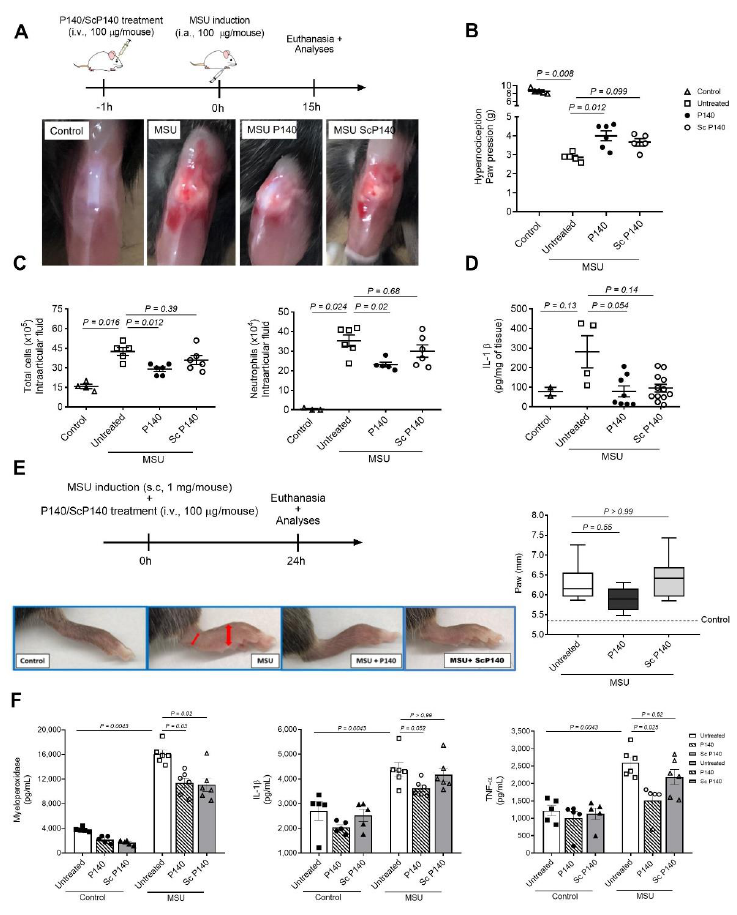
Figure 1. In vivo effect of P140 peptide on two mouse models of gout . ( A ) First mouse model: schedule of treatment (upper panel) and representative images of inflammation site (knee) of control (no MSU — treated), MSU challenged, pre-treated P140 + MSU, and pre-treated Scrambled P140 (ScP140) + MSU mice. In gout (MSU) P140-treated mice the reduction of oedema and inflammation at the level of the knee (lower panel) is depicted. ( B ) Mechanical hypernociception (pain) assessed 15 h after injection of MSU crystals (100 µ g intraarticular–i.a.) by electronic pressure-meter measuring paw withdrawal by flexion of the femorotibial joint in mice treated, or not, with P140 and ScP140 control. ( C ) Number of total cells and neutrophils count in the articular cavity. ( D ) Levels of IL-1 β measured by ELISA 15 h after MSU crystal injection in periarticular tissues. ( E ) Second mouse model: schedule of treatment (upper panel) representative images (lower panel) and size (right panel) of hind paws of control (no MSU-treated), MSU challenged, co-treated P140 + MSU, and co-treated ScP140 + MSU mice (lower panel). Size of hind paws was measured by calliper and expressed in millimetres (mm). ( F ) Levels of MPO and pro-inflammatory cytokines IL-1 β and TNF- α , measured 24 h after